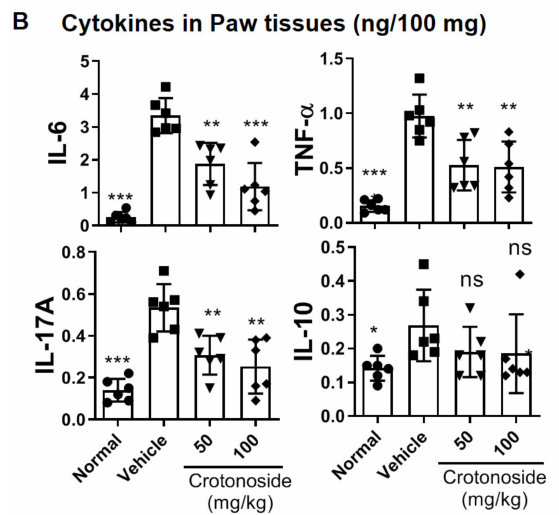
Figure 4. Evaluation of cytokine production in CIA mice ( A ) serum and ( B ) paw tissue homogenate samples under crotonoside treatments. The expression level of proinflammatory cytokines, IL-6, TNF- α , and IL-17A and anti-inflammatory cytokine, IL-10 were determined by ELISA for each tissue sample. Data ( n = 6 per group) is a representative of three experiments. Bar graphs represent the mean ± SD with six mice per group pooled from two independent experiments. * p < 0.05, ** p < 0.01, *** p < 0.001, versus CIA group, as determined by a one-way ANOVA with Dunnett test.